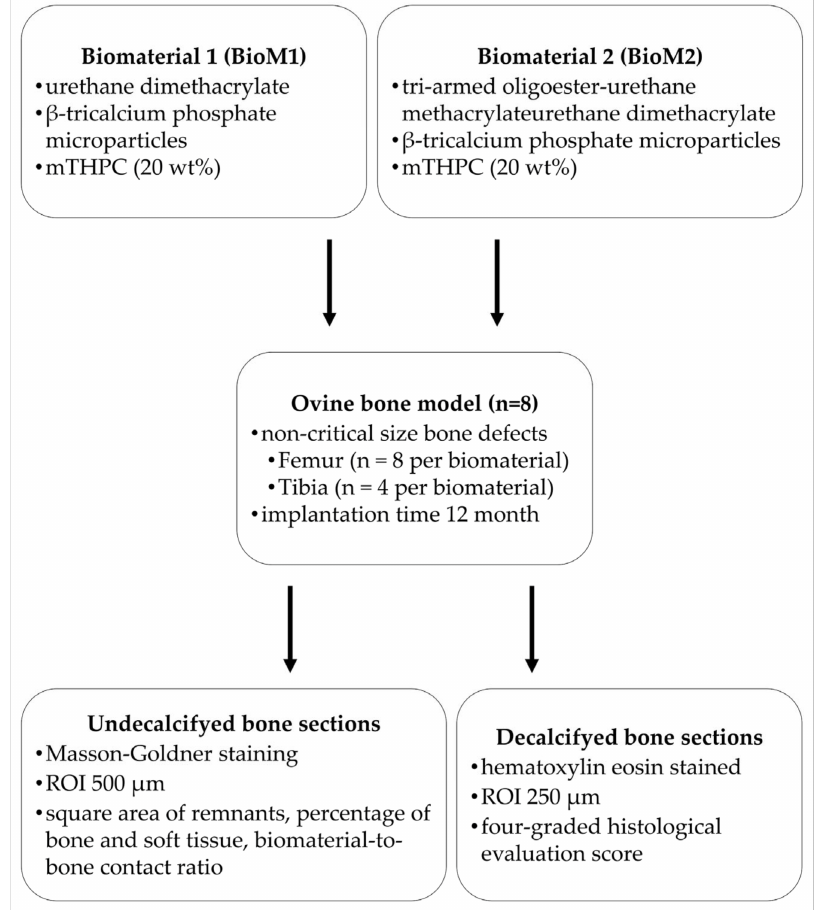
Figure 12. Workflow of the